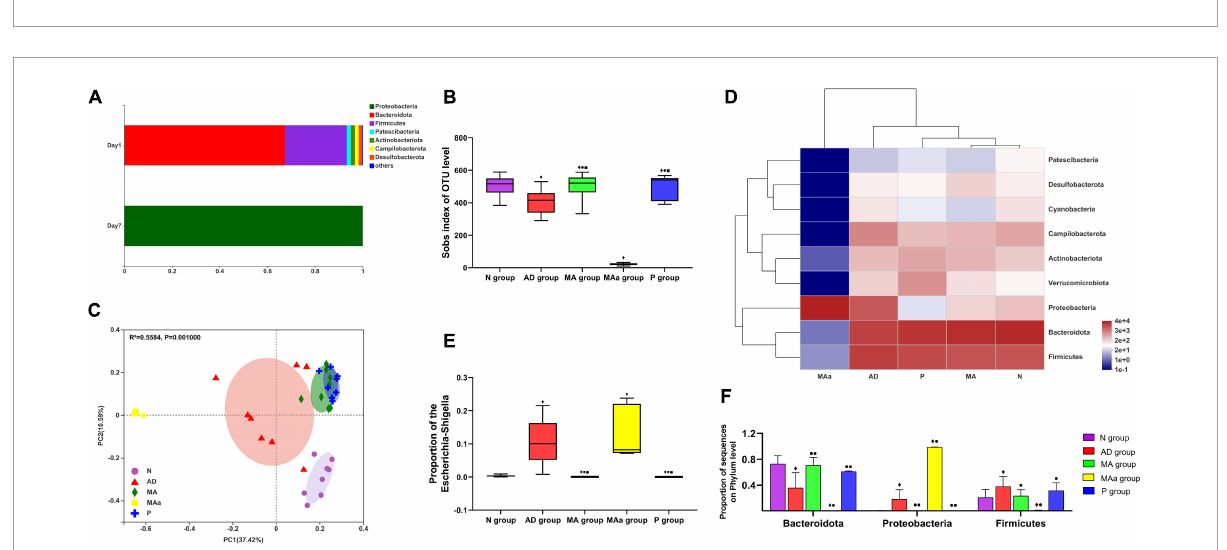
FIGURE2 Results of 16S rRNA for each group ( n = 8, mean ± SD). (A) Community barplot analysis in the MAa group. (B,C) Sobs index and PcoA analysis in each group. (D) Heatmap at the phylum level in each group. (E,F) Comparison of the abundance of phylum and genus in each group. Compared to the N group, (cid:7) p < 0.01 or p < 0.05. Compared to the AD group, • p < 0.01 or p < 0.05. Compared to the MAa group, (cid:4) p < 0.01 or p <